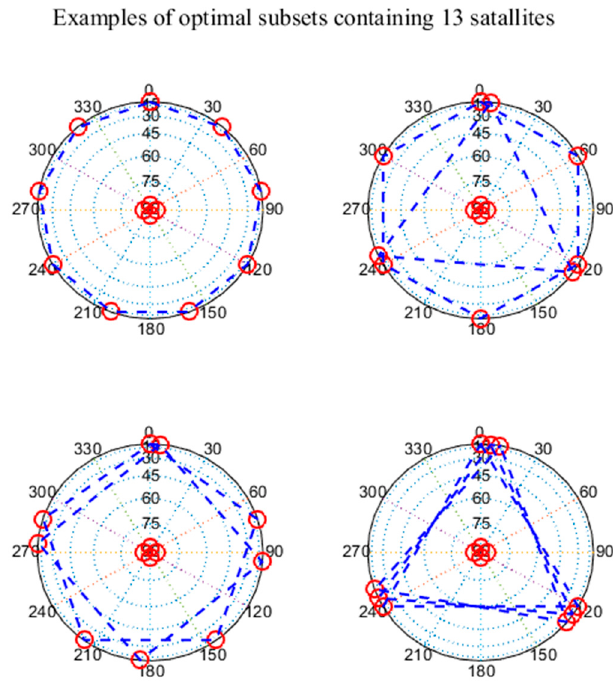
Figure 1. Skyplots of optimal subsets containing 13 satellites obtained with the Geometric Dilution of Precision (GDOP) method.